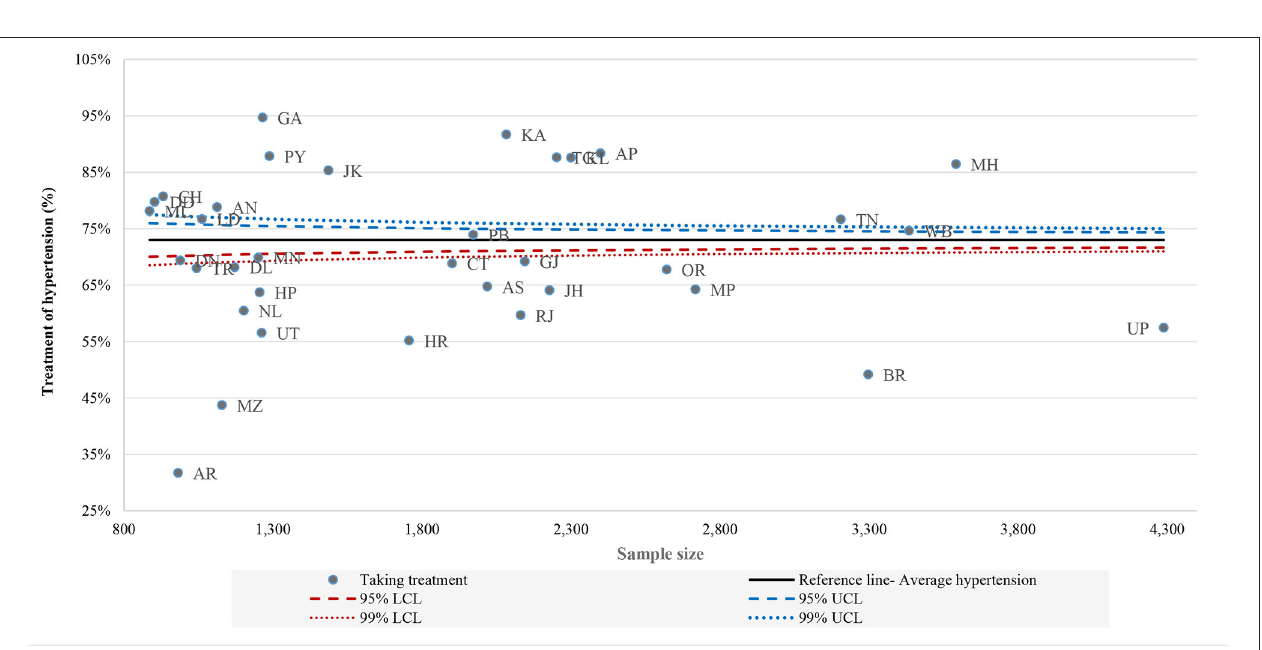
FIGURE 1 | Funnel plot of performance of states: diagnosis of hypertension, LASI (2017–18).